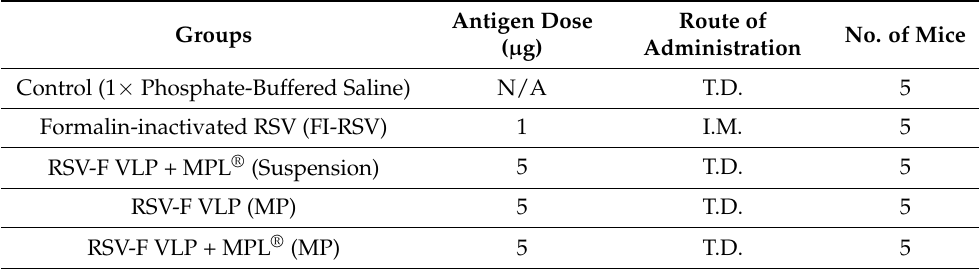
Table 1. Groups for animal study. Mice ( n = 5, per group) were dosed with RSV-F VLP with or without adjuvant. The control group of mice was administered PBS and served as the negative control, while the formalin-inactivated RSV (FI-RSV) administered group was selected as a positive control. Antigen Dose Route of Groups No. of Mice ( µ g) Administration Control (1 × Phosphate-Buffered Saline) N/A T.D. 5 Formalin-inactivated RSV (FI-RSV) 1 I.M. 5 RSV-F VLP + MPL ® (Suspension) 5 T.D. 5 RSV-F VLP (MP) 5 T.D. 5 RSV-F VLP + MPL ® (MP) 5 T.D.